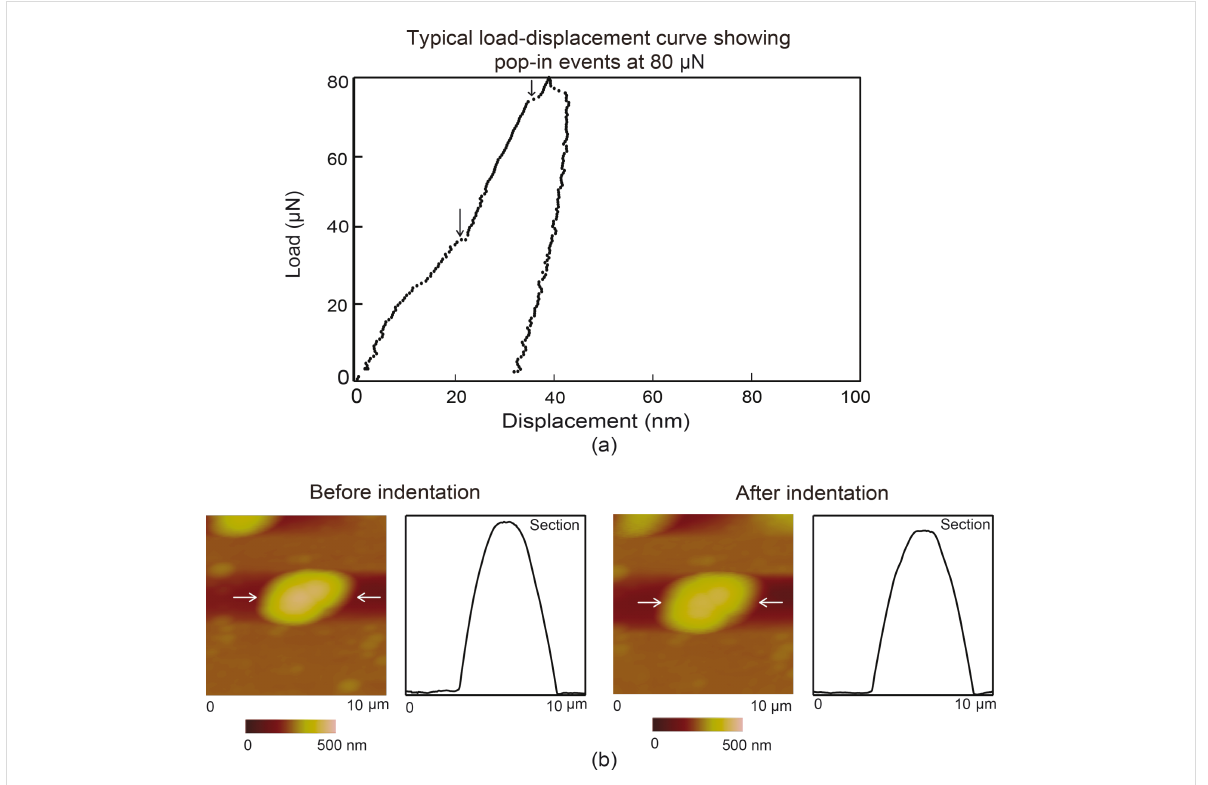
Figure 10: (a) Typical load displacement compression curve at a maximum load of 80 µN for Au 500 with vertical arrows showing pop-in events and (b) topography maps and 2-D profiles at sections shown by the arrows before compression (first row) and after compression (second